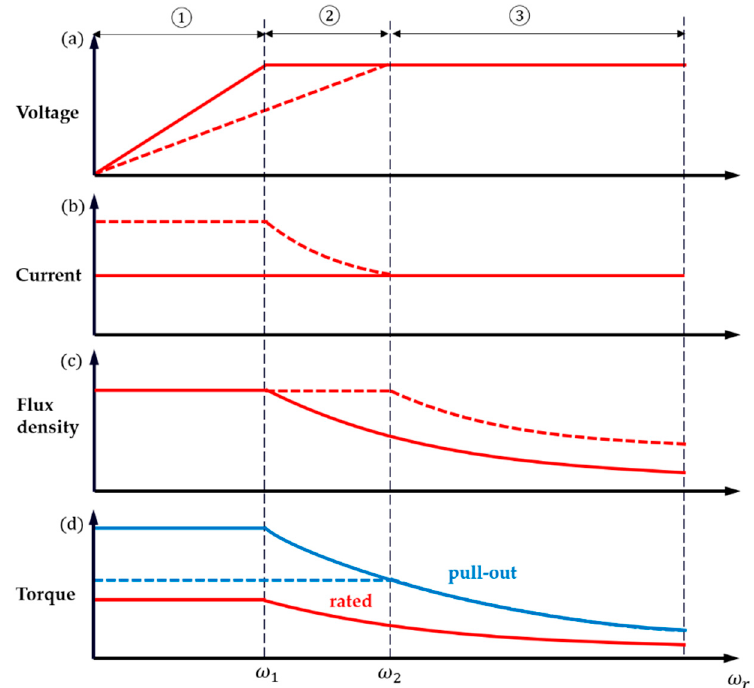
Figure 3. Conventional ( − ) and extended full flux range (--) induction motor (IM) design behavior: ( a ) Stator voltage magnitude; ( b ) Stator current magnitude; ( c ) Flux density; ( d ) Electromagnetic torque (rated&pull-out). Both machines are designed to provide the same torque vs. speed characteristic and have the same voltage limit.